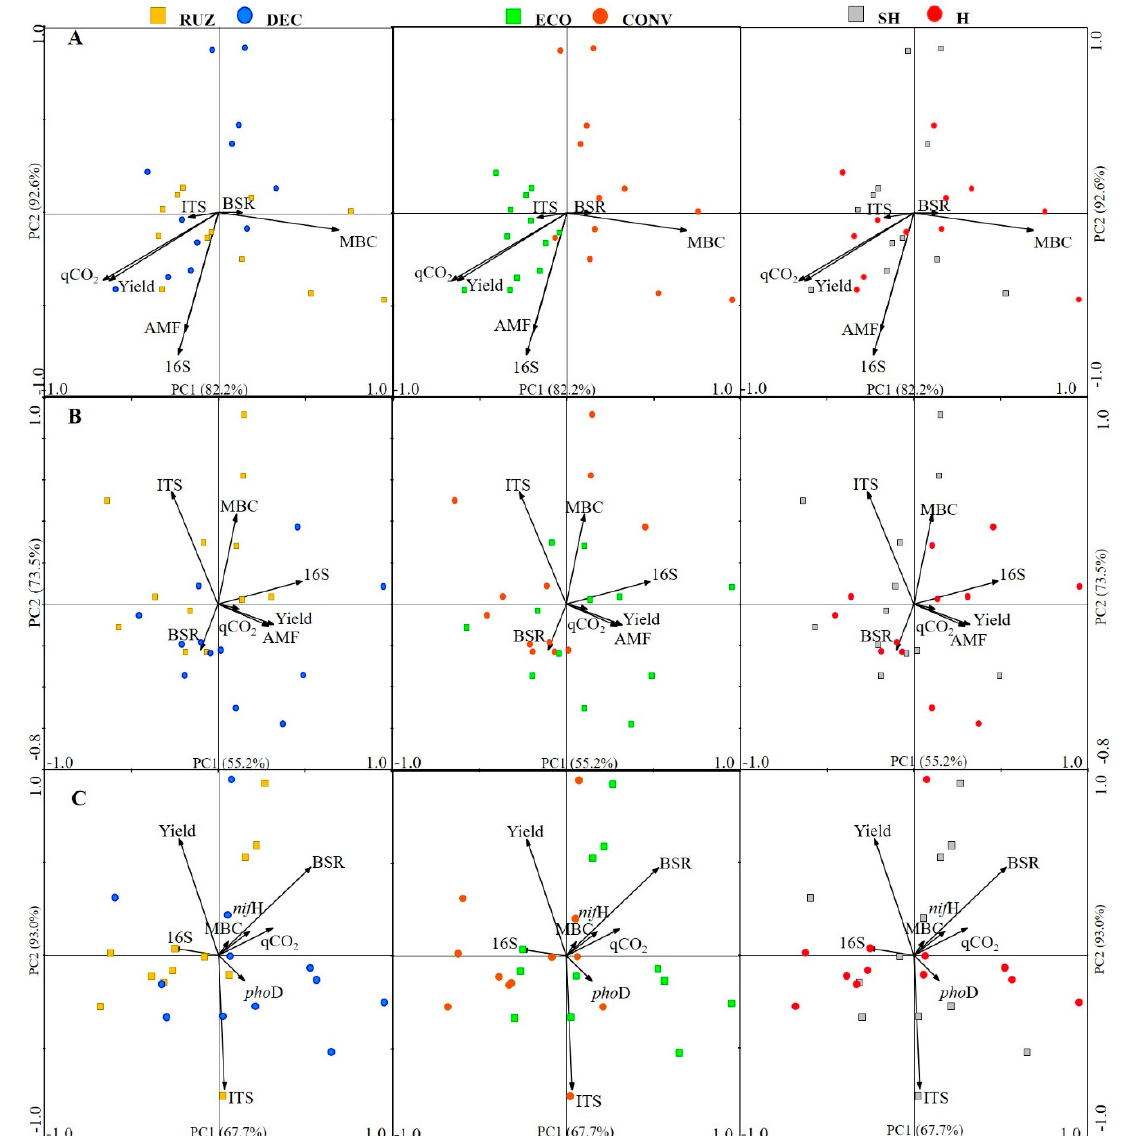
Figure 9. Redundancy analysis based on biplot distance from the fungal community (Bray–Curtis) in a Tahiti acid lime orchard, under testing with different cover crops, mowers, and the use of glyphosate (Mogi Mirim, São Paulo, 2016–2019). Legend: RUZ = Urochloa ruziziensis (yellow squares), DEC = U. decumbens (blue circles), ECO = ecological mower (green squares), CONV = conventional mower (orange circles), H = glyphosate herbicide (1080 g ae. ha − 1 ) (red circles), NH = no herbicide (gray squares). Orchard age: growing season, 2016–2017 ( A ), 2017–2018 ( B ) and 2019–2020 ( C ).